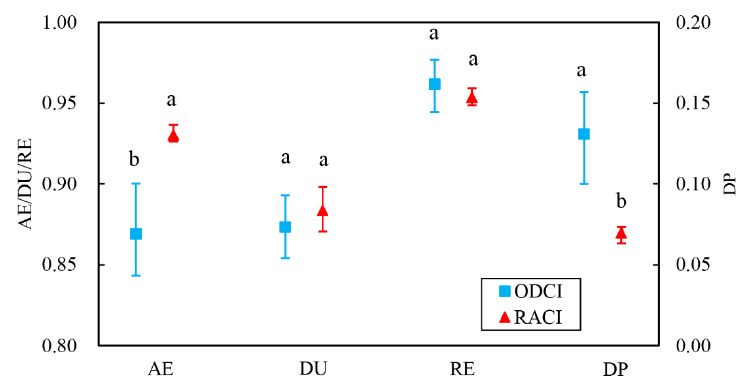
Figure 5. Experimental results for border irrigation for AE, DU, RE, and DP. The vertical bars labeled with “a” and “b” for each irrigation performance indicator indicate significant differences at p = 0.05 based on the independent sample t ‐ test.